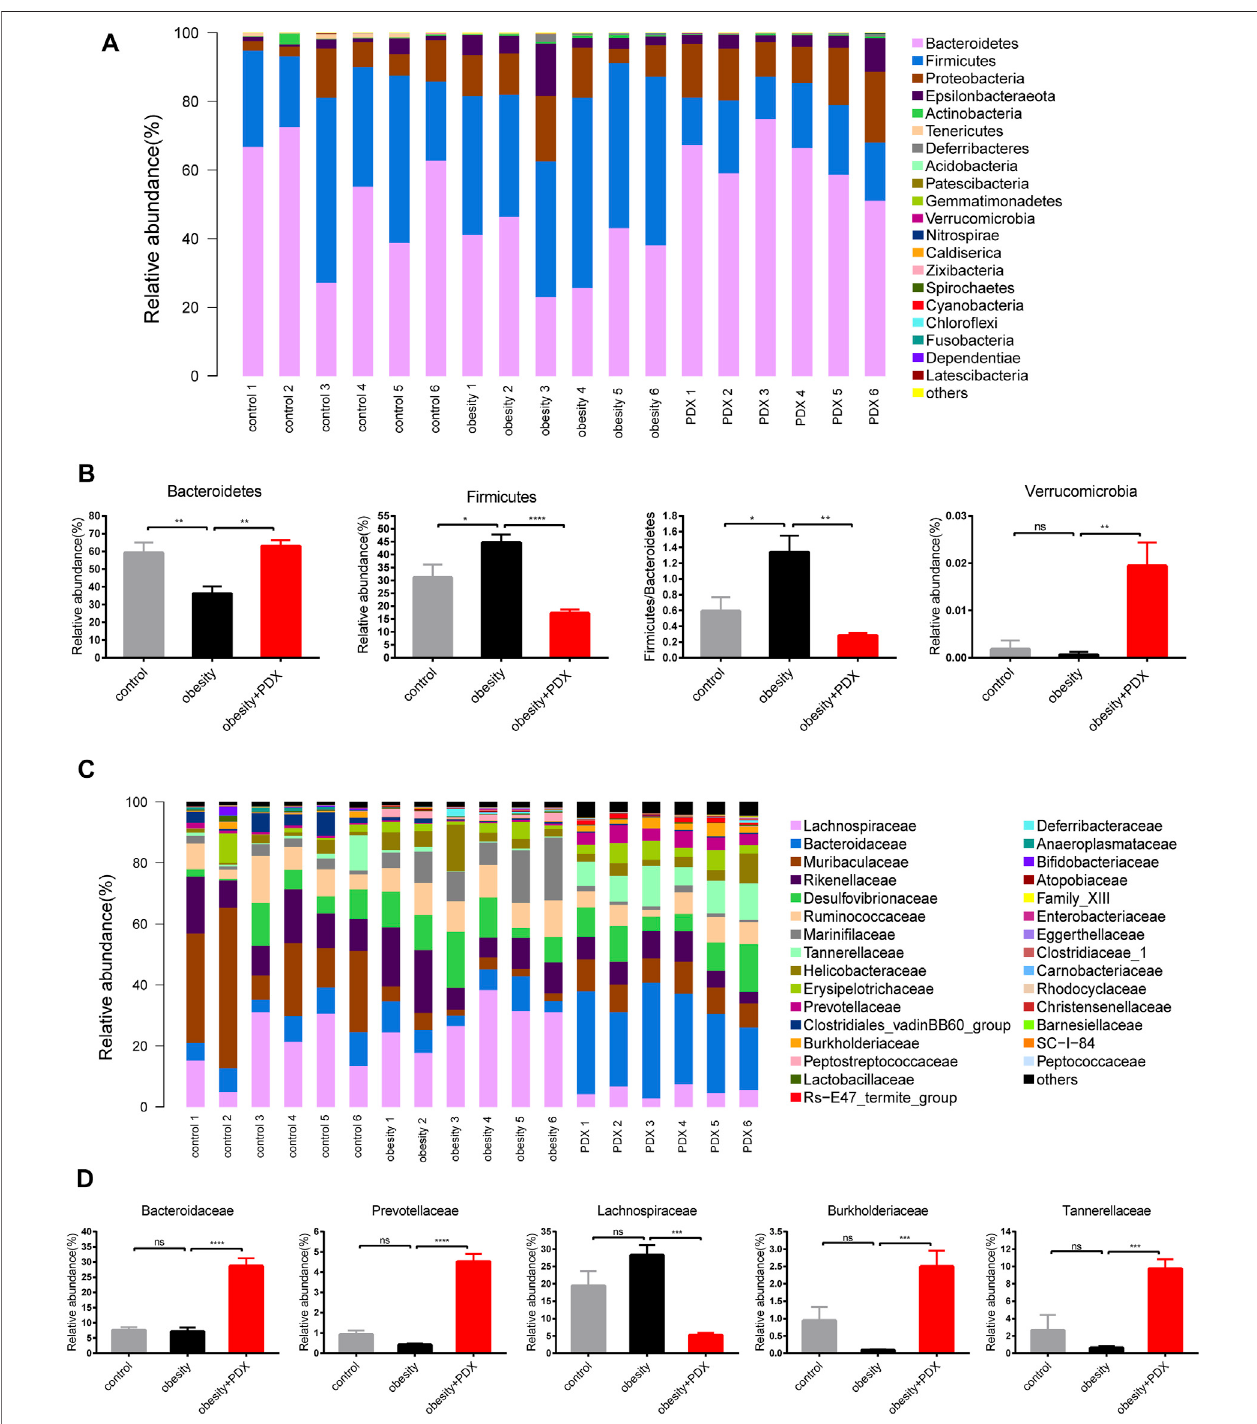
FIGURE 9 | PDX modulated the composition of gut microbiota at the phylum and family level in HFD-induced obese mice (Part 2). (A) Relative abundance of microbial taxa at the phylum level. (B) Relative abundance of Bacteroidetes , Firmicutes , Verrucomicrobia and Firmicutes/Bacteroidetes ratio. (C) Relative abundance of microbial taxa at the family level. Top 30 abundances are shown. (D) Relative abundance of Bacteroidaceae, Prevotellaceae, Lachnospiraceae, Burkholderiaceae and Tannerellaceae . n (cid:2) 6 per group. * p < 0.05; ** p < 0.01; *** p < 0.001; **** p < 0.0001; ns, not statistically signi fi cant.